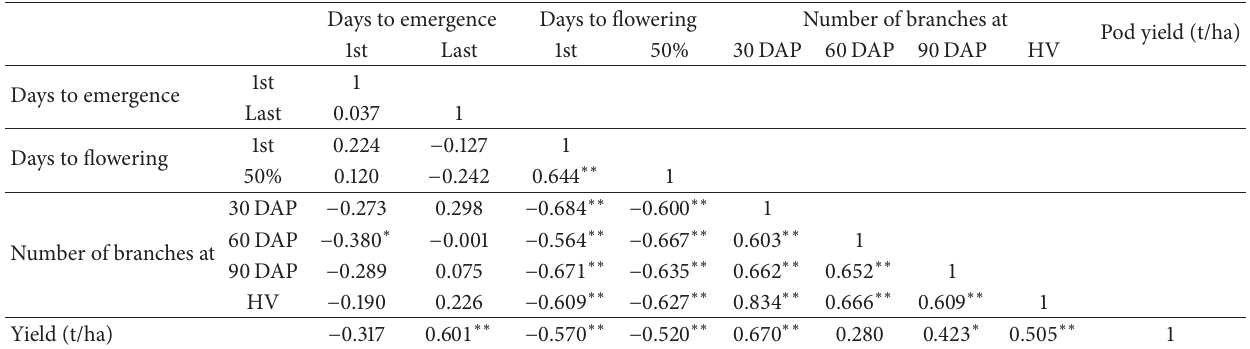
Table 6: Pearson correlation coefficient ( 𝑟 ) among the days to emergence, days to flowering, and pod yield of peanut (mean of two trials). Days to emergence Days to flowering Number of branches at Last